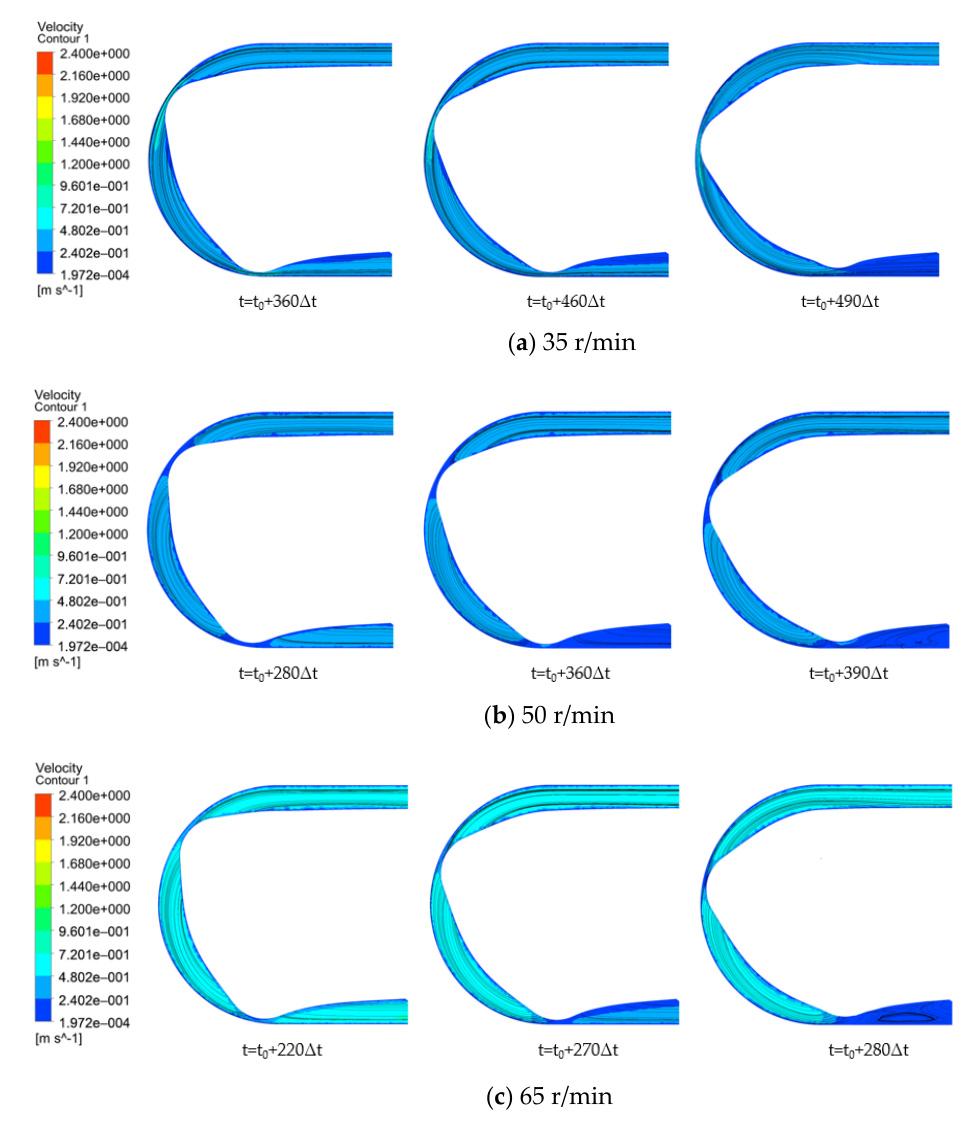
Figure 12. Flow line diagram of the 0 MPa outlet pressure at different speeds.